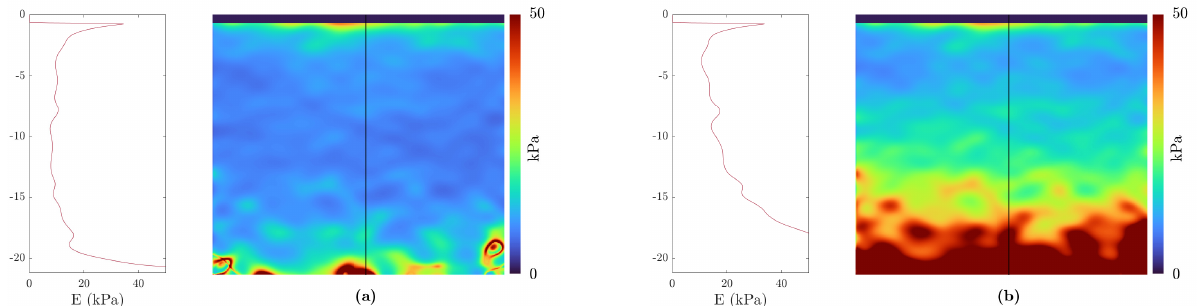
Figure 11. Comparison between the two different stress assumptions of the estimated Young’s modulus of a homogeneous specimen: ( a ) Love’s stress estimation; ( b ) Plane–stress assumption. The black line in the elastogramm marks the cross- section, which is plotted in the left